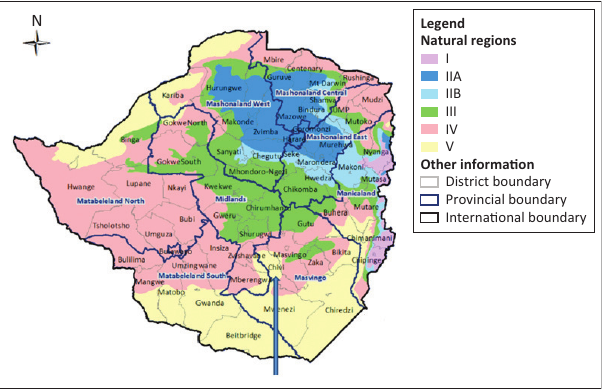
FIGURE 1: Map for Chivi District in Zimbabwe. Arrow showing Chivi District in